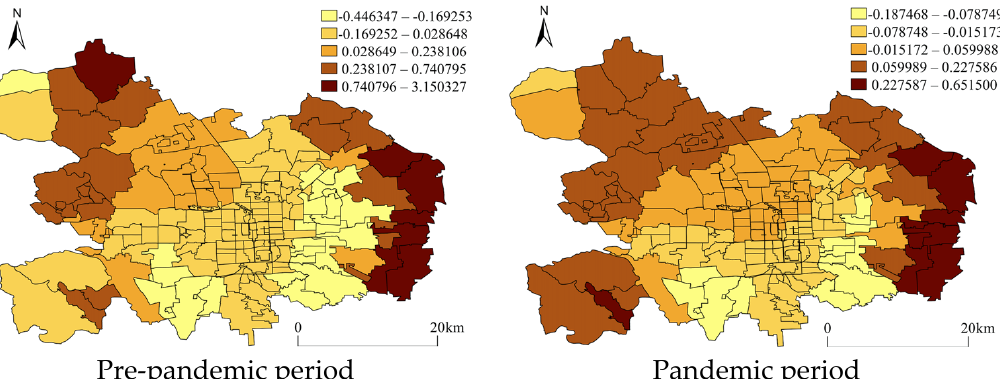
Figure 5. Coefficients of gym rooms from GWR with residential burglary. The coefficients were categorized by using natural breaks.